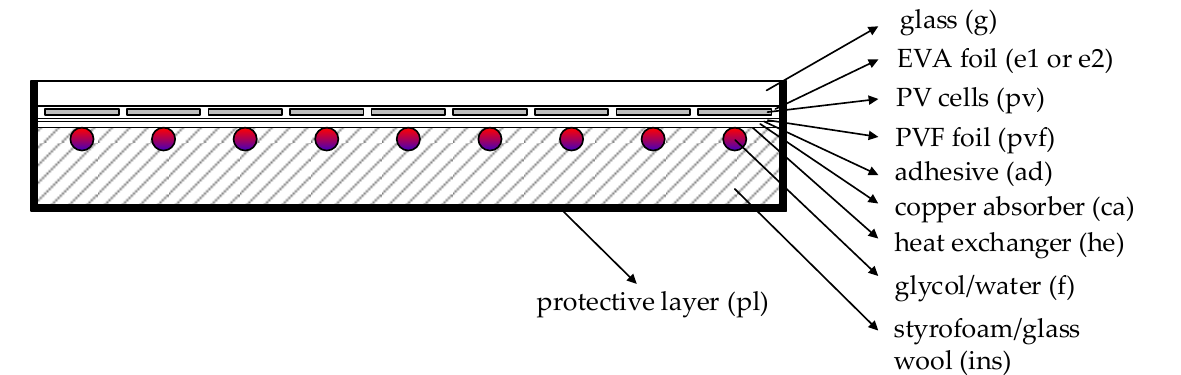
notation of the temperature distribution of each layer separately is illustrated below.